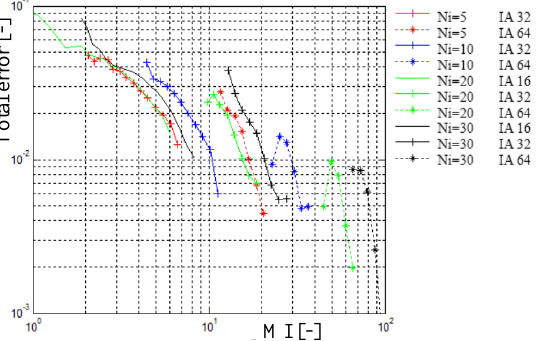
Fig. 4. Influence of seeding density and interrogation area size for